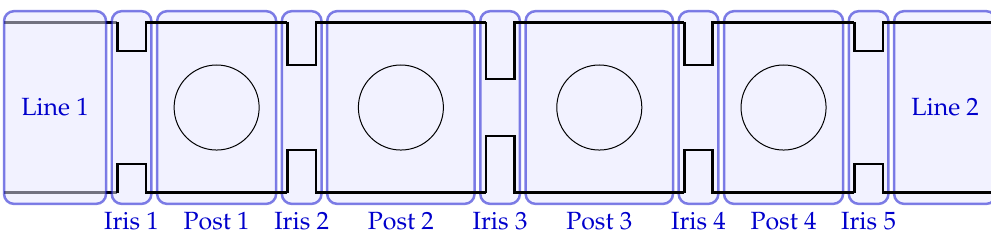
Figure 8. Segmentation of the dielectric loaded filter into simple blocks (empty lines, irises, and dielectric posts).